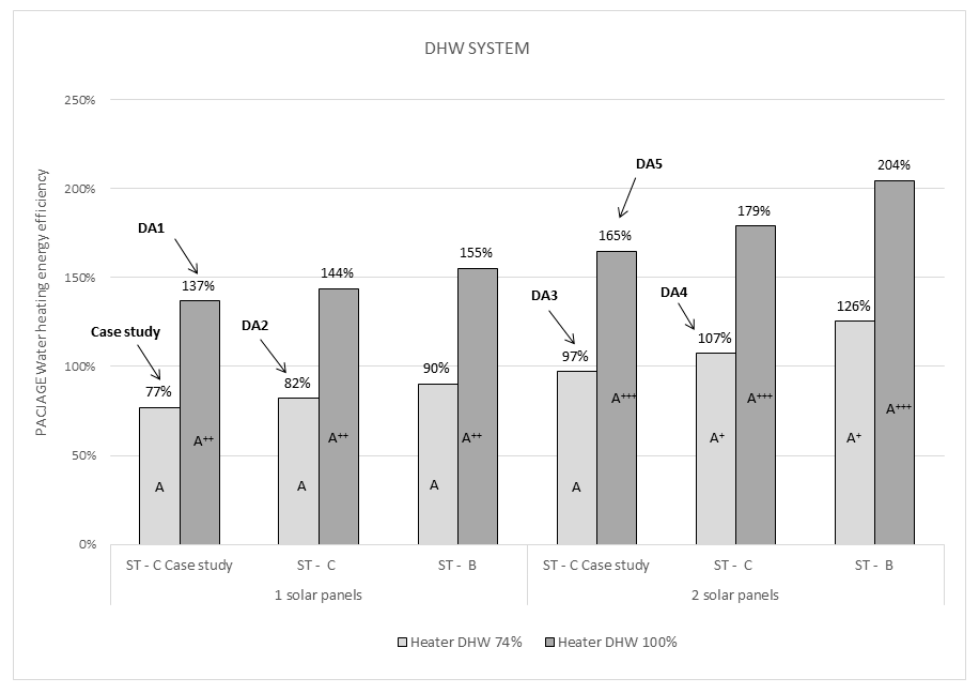
Figure 8. Combined options to improve the water heating energy efficiency of the package.